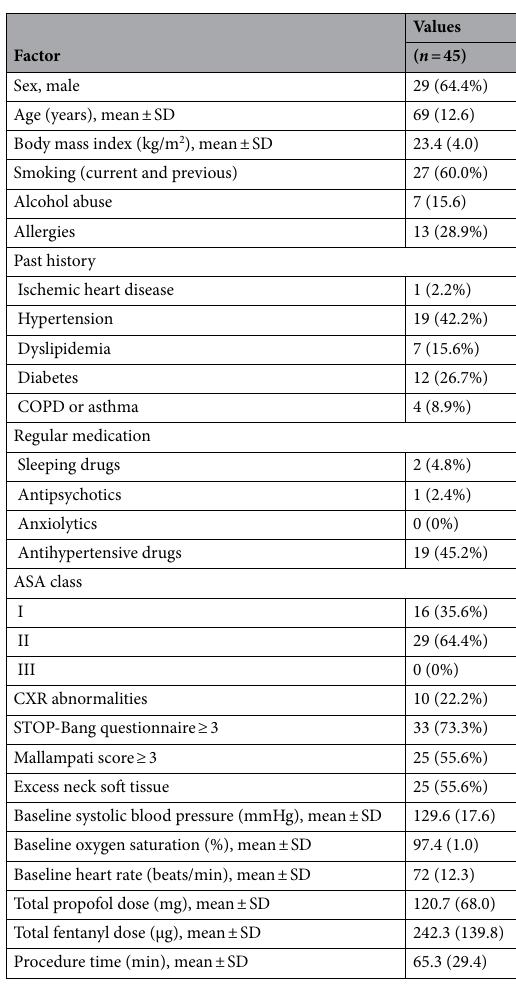
Table 1. Patient demographic information and indications for procedure. Values are presented as n (%), unless otherwise specified, values are presented as n (percent). The STOP-Bang questionnaire consists of eight dichotomous (yes/no) questions: (1) snoring, (2) daytime fatigue, (3) observed apnea, (4) high blood pressure, and (5) BMI ≥ 30, (6) age ≥ 50 years, (7) neck circumference ≥ 40 cm, and (8) male sex. The total score ranges from 0 to 8. ASA American Society of Anesthesiologists, COPD chronic obstructive pulmonary disease, CXR chest X-ray, SD standard deviation.